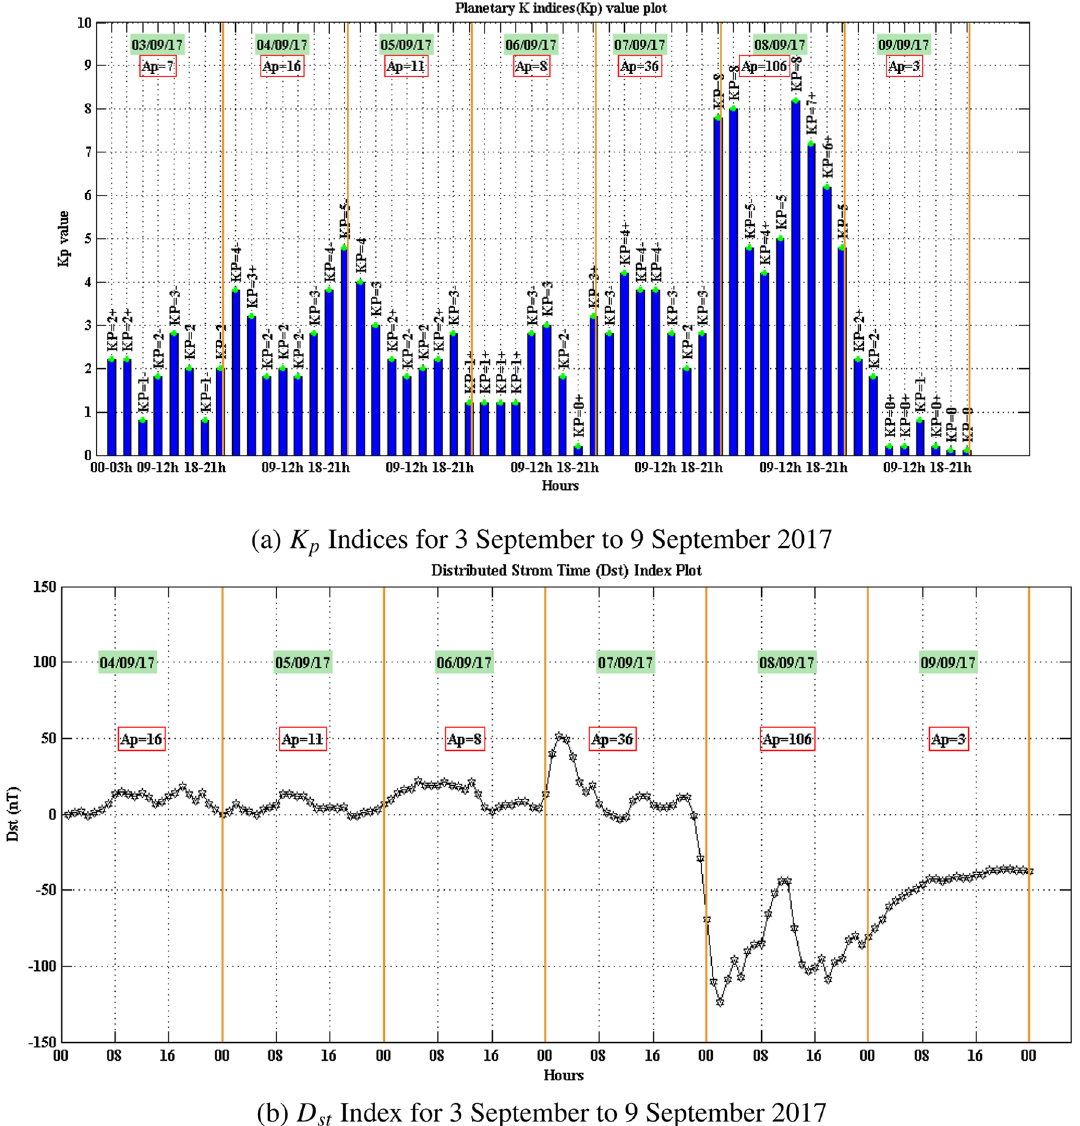
Fig. 3. Graphical representation of various geomagnetic